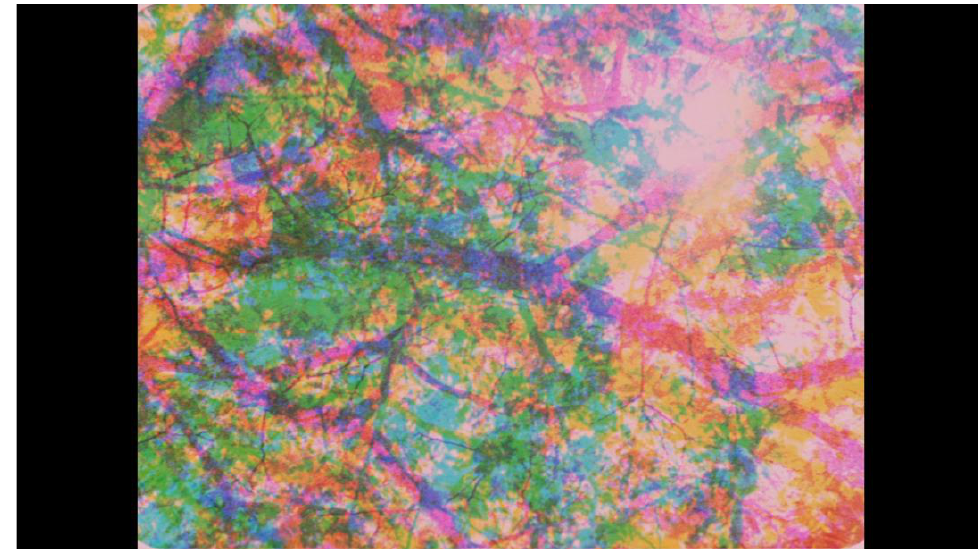
Figure 2. Nova Paul, This is Not Dying , 2010, 16mm film, 30 min (still).